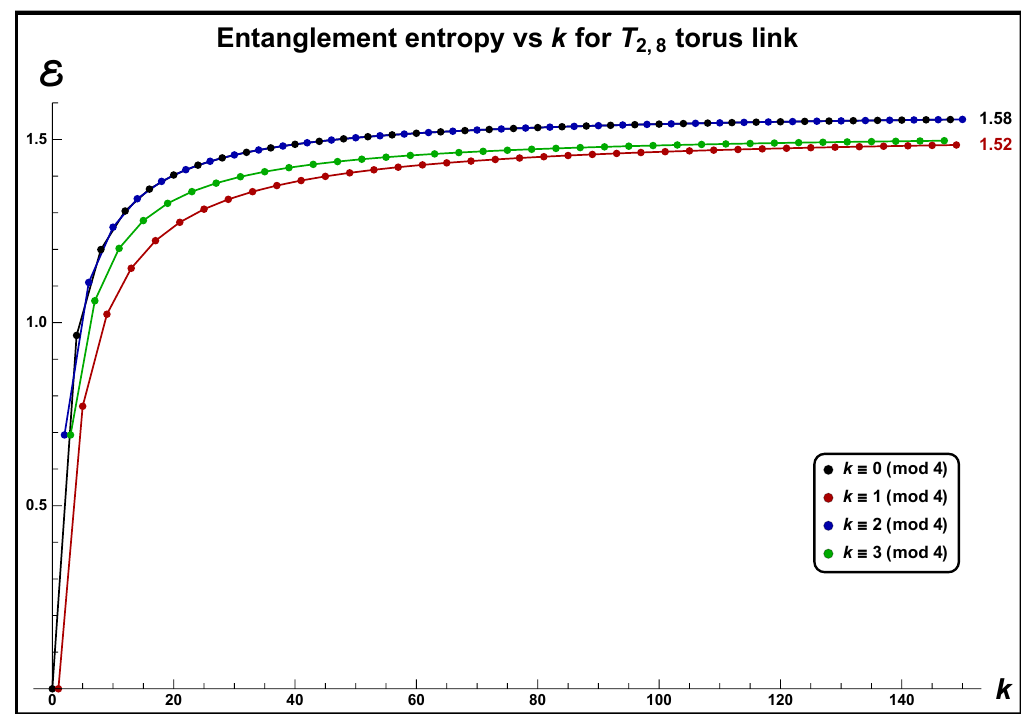
Figure 8. The variation of the SU (2) k entanglement entropy with k for T 2 , 8 torus link. The plots are shown for values of ‘ = 0 , 1 , 2 , 3 where k ≡ ‘ ( mod 4) . As k becomes large, the entropies for ‘ = 0 , 2 and ‘ = 1 , 3 respectively converge to same values as given in (4.39). The corresponding asymptotic values up to 2 decimal places have been indicated against the